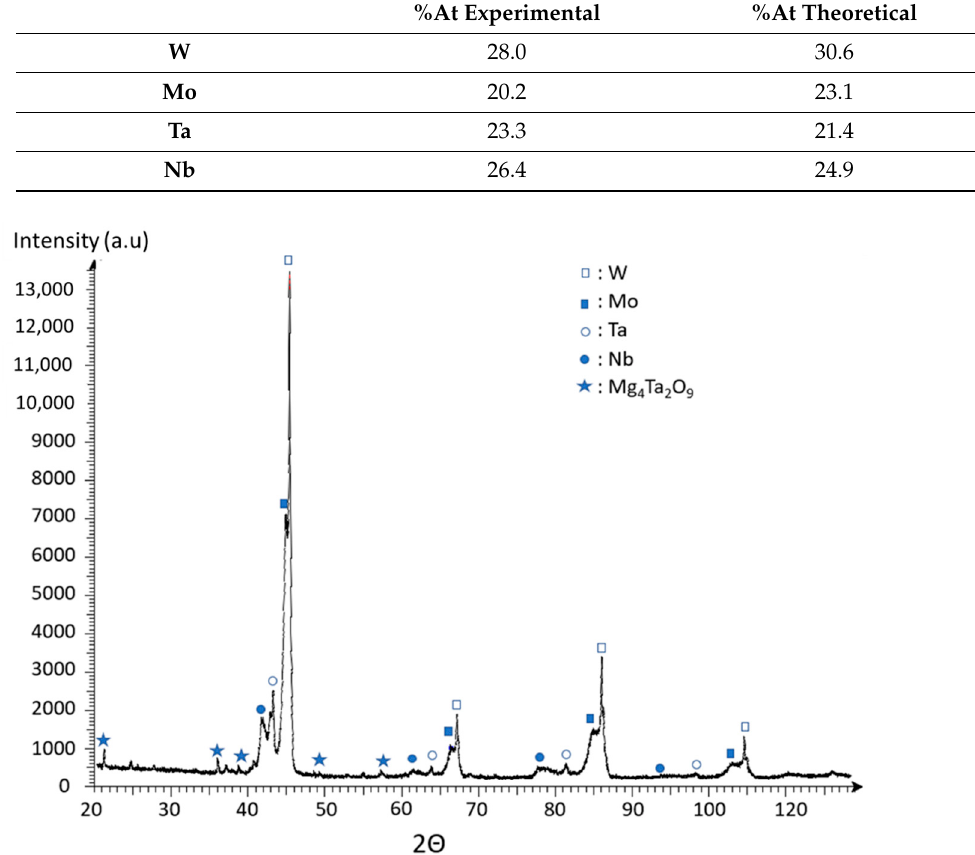
Figure 2. X ‐ ray diffractogram of WmoTaNb powder prepared by SHS. Figure 2. X-ray diffractogram of WmoTaNb powder prepared by